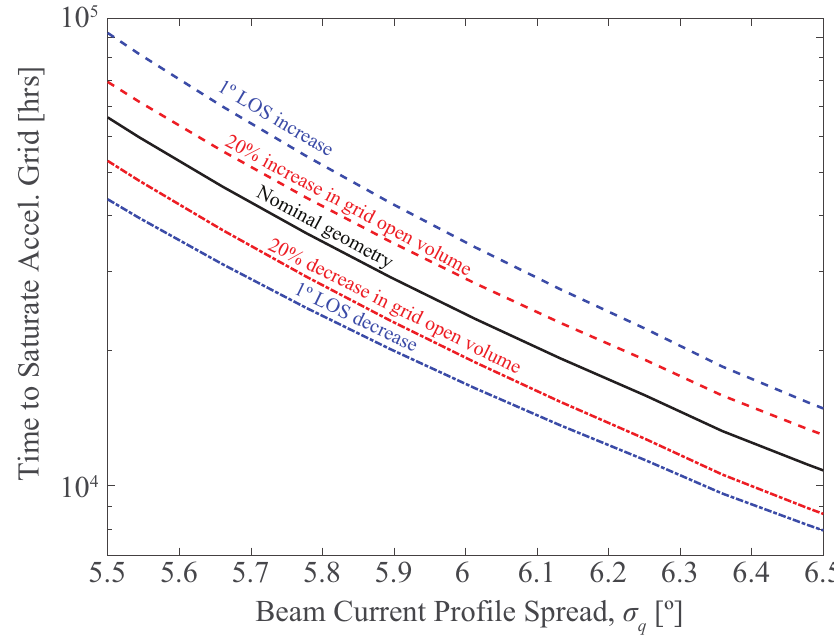
Figure 7. The effects of geometry changes, porous grid capacity, and beam shape (indicated by standard deviation) on accelerator grid saturation time.